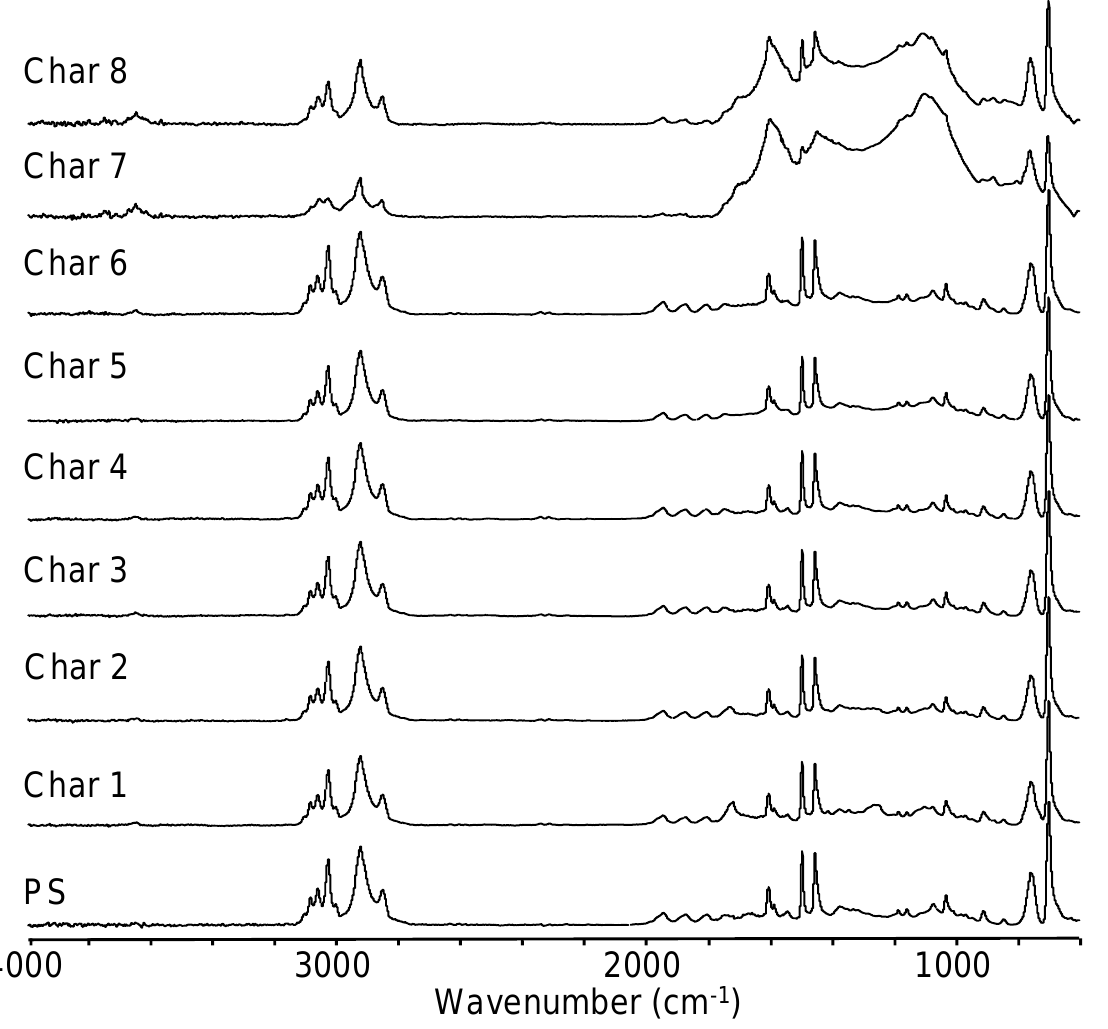
Figure 7. FTIR spectra of PS and char samples.